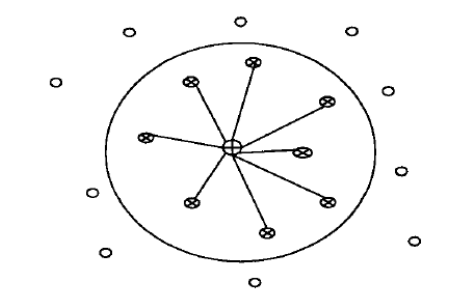
Fig. 1 Searching diagram of k nearest neighbors